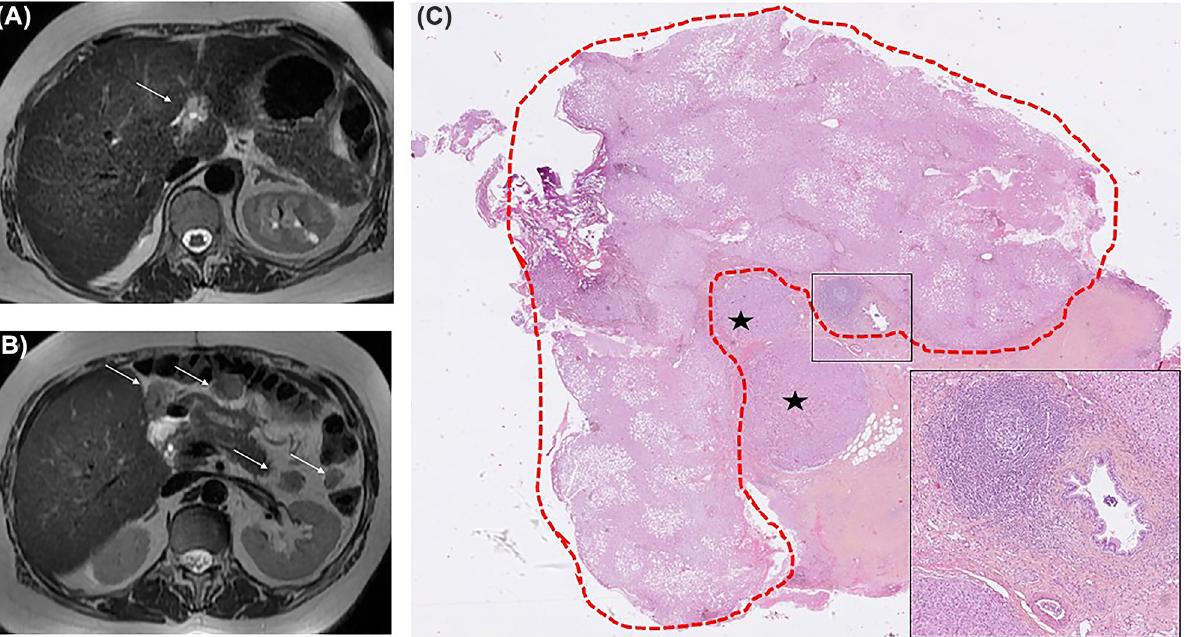
Figure 1: Magnetic resonance imaging (MRI) of the liver and peritoneum (axial T2 weighted images). (A) Initial MRI: ill-defined T2 hyperintense nodule within the falciform ligament of the liver (arrow). (B) MRI at 3 months: Appearance of several peritoneal metastases (arrows). Note the absence of any parenchymal liver tumour in both images. (C) Histopathological analysis: hepatocellular carcinoma (asterisks) in the falciform ligament of the liver, representing the starting point of the peritoneal disease. Ectopic liver is circled in red (greater axis: 15 mm), with detectable steatosis (HES, × 6). Note the independent vasculo-biliary stalk, highlighted in the inset (HES, × 50). HES: